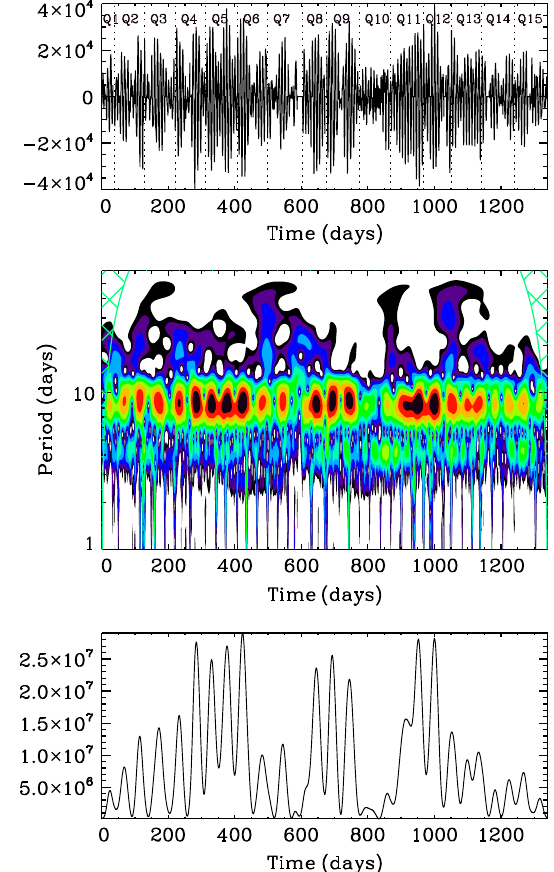
Fig. 4. Top : time series of the star KIC 5210507 corrected as described in Section 2. Middle : Wavelet Power Spectrum as a function of time and period. Dark and red colours correspond to high power while blue and purple colours correspond to low power. The green grid corresponds to the cone of influence that delimits the reliable regions of the WPS by taking into account edge effects. Bottom : Scale-average variance obtained by projecting the WPS on the time axis around the rotation period of the star (8.43 days).